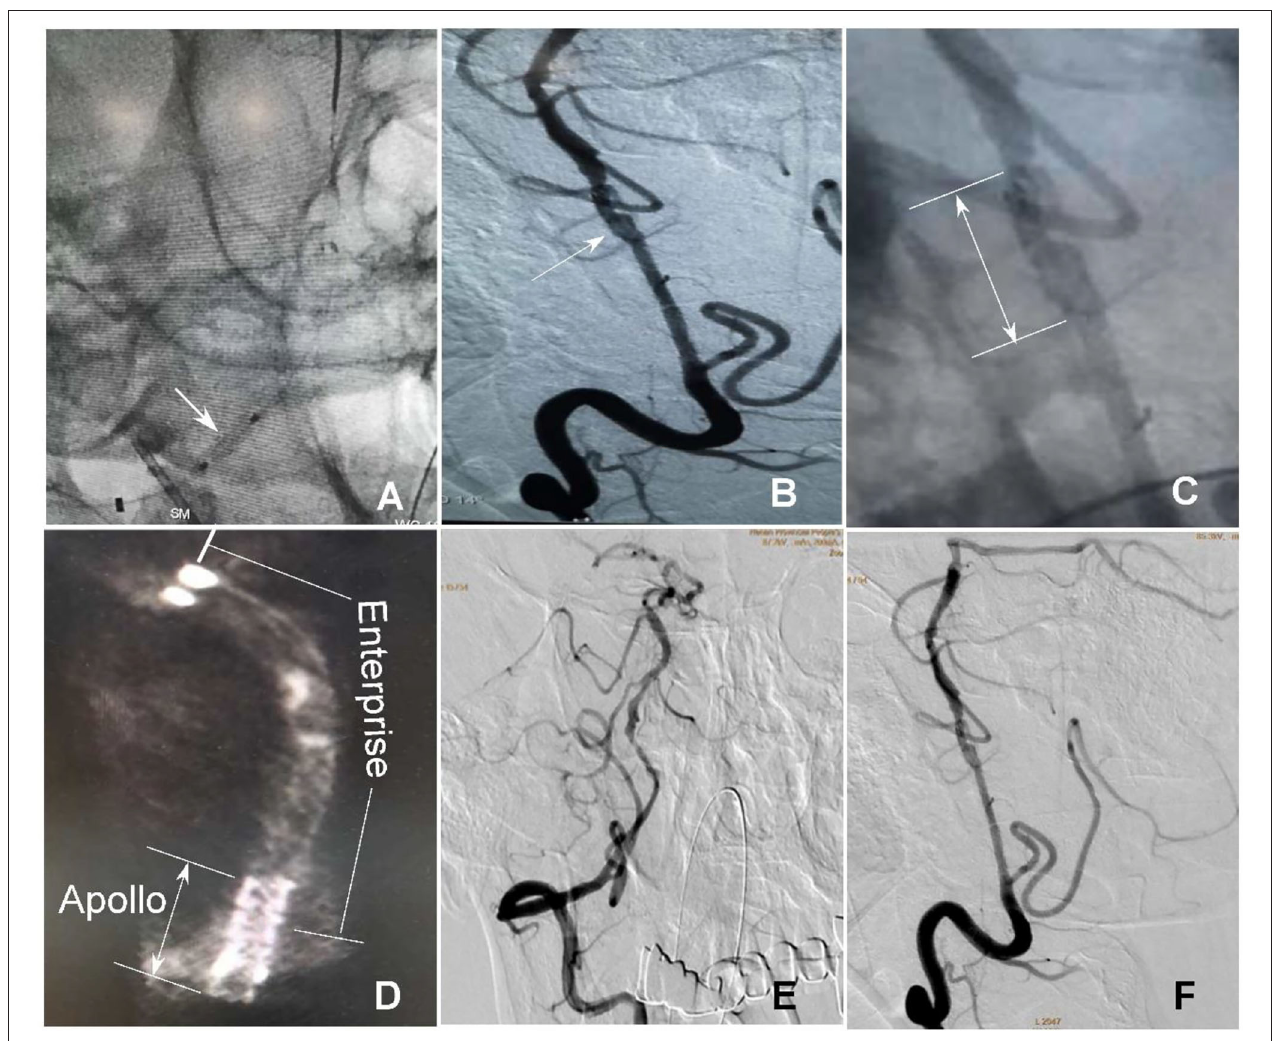
FIGURE 4 | Rescue management of the collapsed stent end. (A) An Apollo stent (2.5 × 10mm) was navigated along the 200-cm micro-guidewire to the proximal end of the Enterprise stent and expanded for deployment (arrow). (B) The Apollo stent was deployed to partially overlap with the Enterprise stent (arrow). (C) The arrow indicates the deployed Apollo stent. (D) DynaCT scan demonstrated partial overlap of the distal Enterprise stent with the proximal Apollo stent. (E,F) After stenting, both stents were well-patent with favorable forward